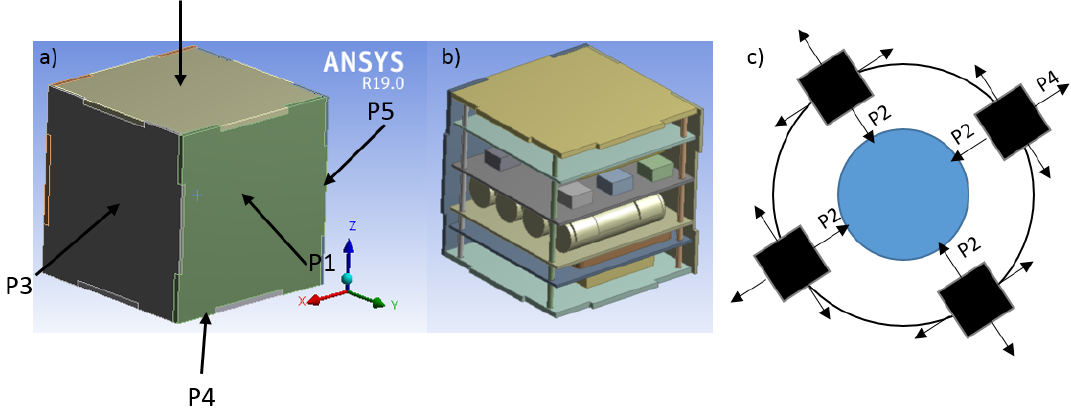
Figure 1. Conceptual design of the CubeSat primary structure, ( a ) external composite panels ( b ) internal electronic devices arrangement and ( c ) panels configuration and Nadir-pointing scenario